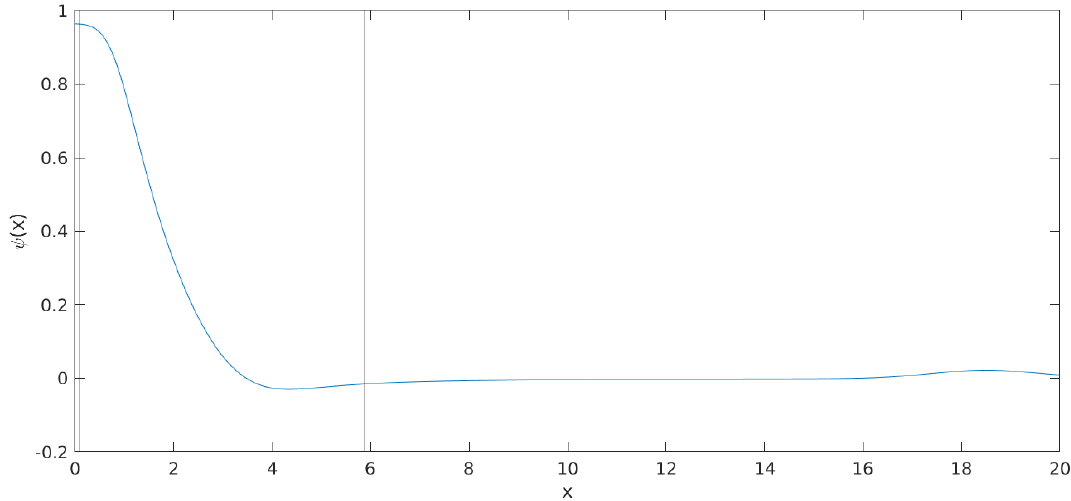
Figure 4: A late time scalar profile. Note the vertical line very close to the origin which is the spurious apparent horizon. Note also that the outer (true) apparent horizon covers up the whole